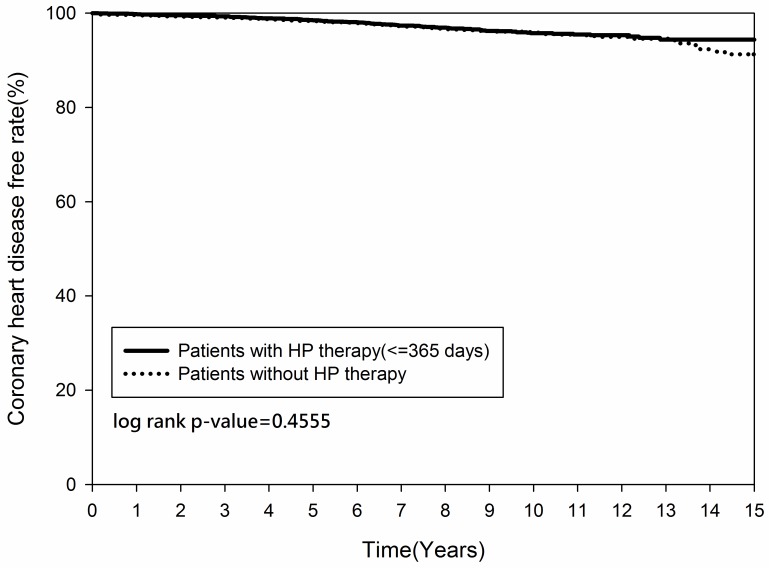
Kaplan-Meier curve for coronary heart disease rate between patients with and without Helicobacter pylori therapy.